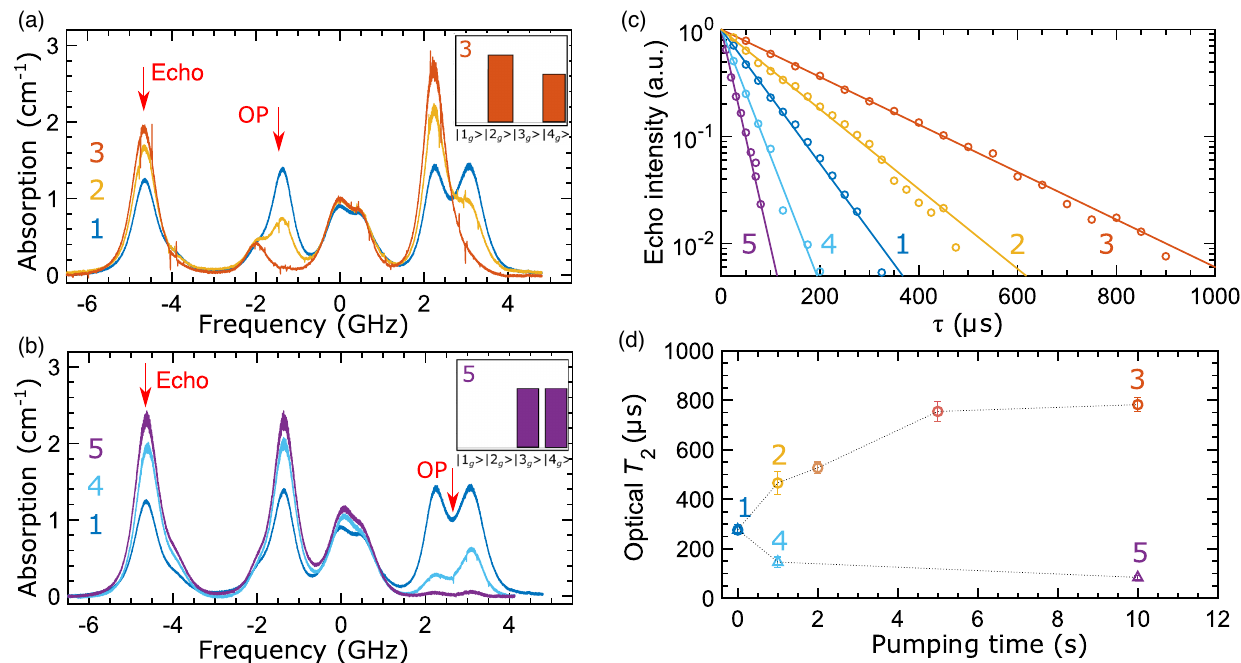
¼ 0 . 02 (cid:2) 0 . 02 , 0 . 02 (cid:2) 0 . 02 , 1 . 95 (cid:2) 0 . 10 , , k 2 , k 3 , k 4 g g g g